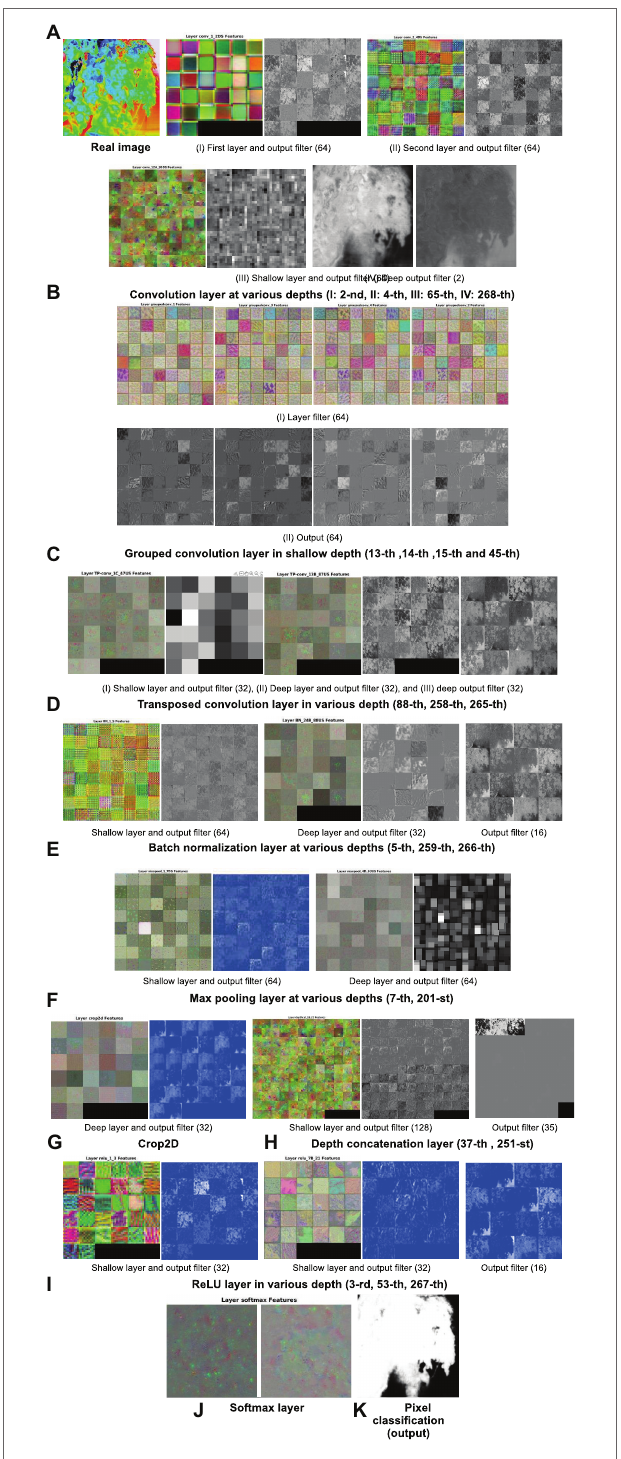
FIGURE 8 | Feature maps and visualization of the network. (A) Visualization of the first and second layer. (B) Convolution layer at various depths. (C) Grouped convolution layer at various depths. (D) Transposed convolution layer at various depths. (E) Batch normalization layer at various depths. (F) Max pooling layer at various depths. (G) Visualization of the crop2D. (H) Visualization of the depth concatenation layer. (I) ReLU layer at various depths. (J) Visualization of the softmax layer. (K) Visualization of the